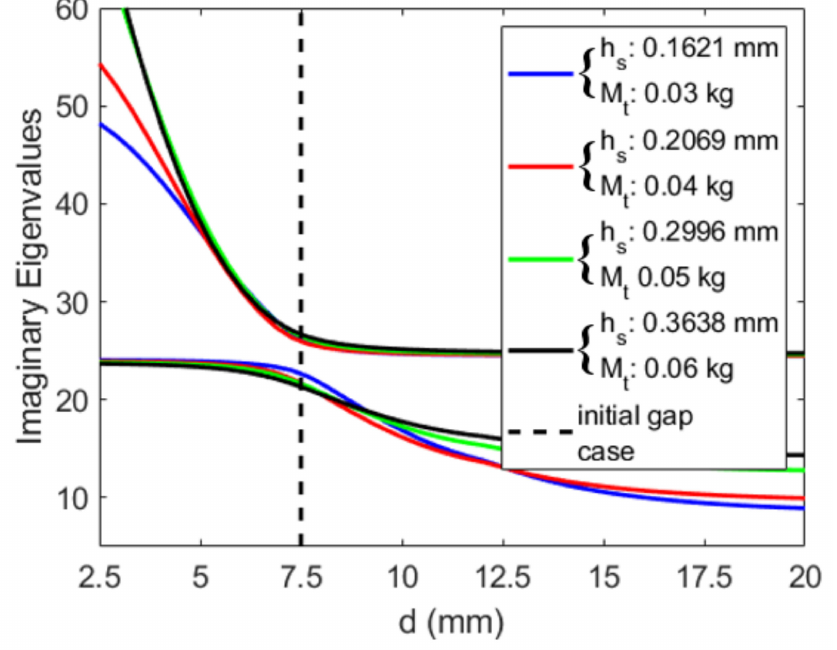
Figure 25. The initial gap’s effects on the coupled natural frequency of varying tip masses with its paired substrate